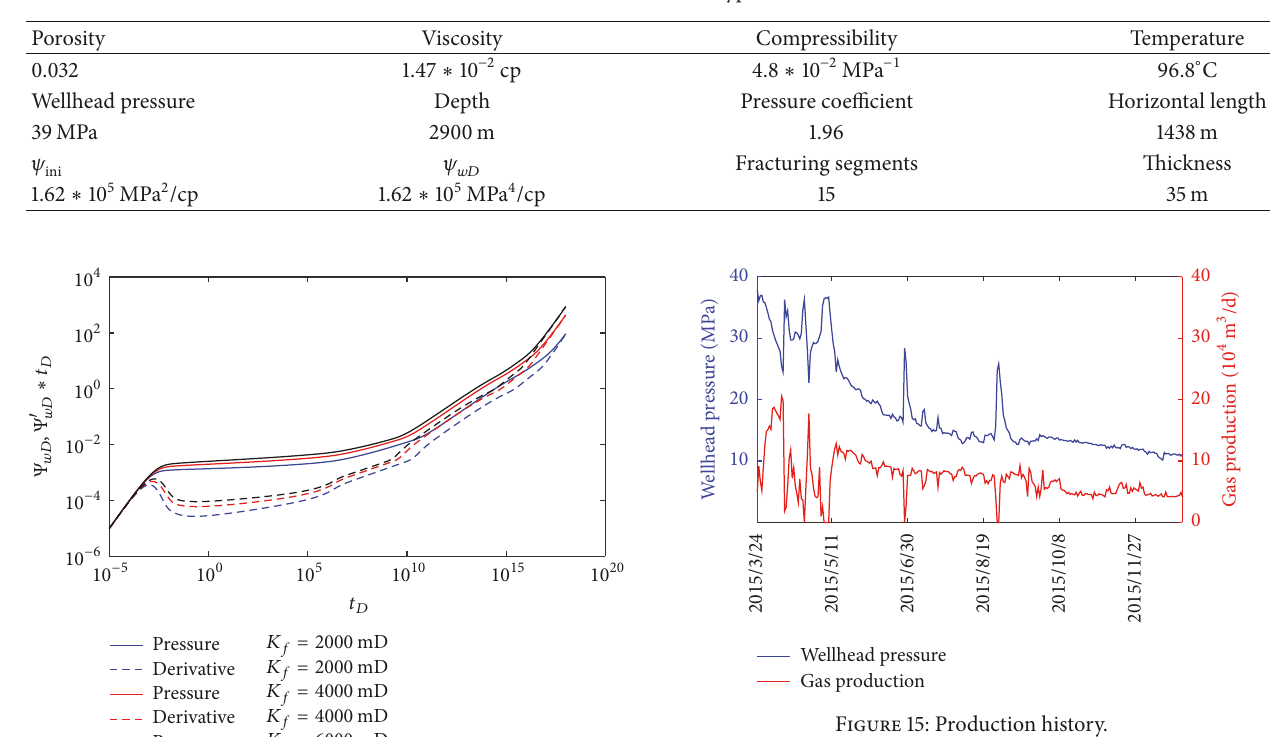
Table 4: Parameters of the typical well.